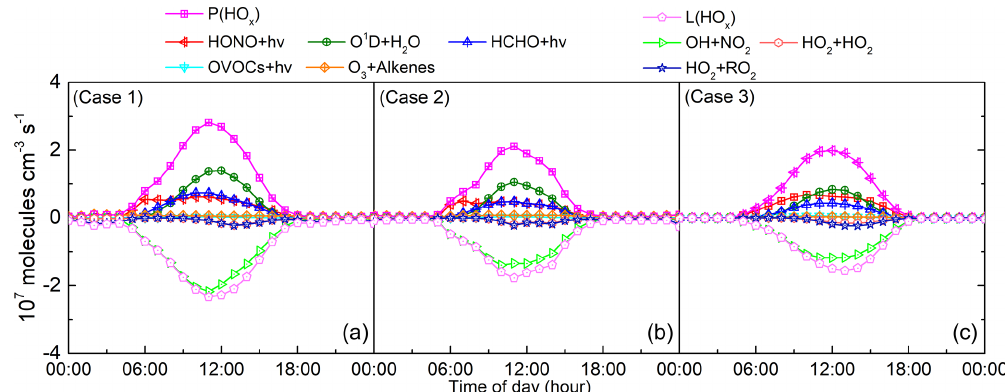
Figure 6. The average diurnal profiles of HO x sources and sinks in (a) Case 1, (b) Case 2 and (c) Case 3 at an urban site of Shanghai.